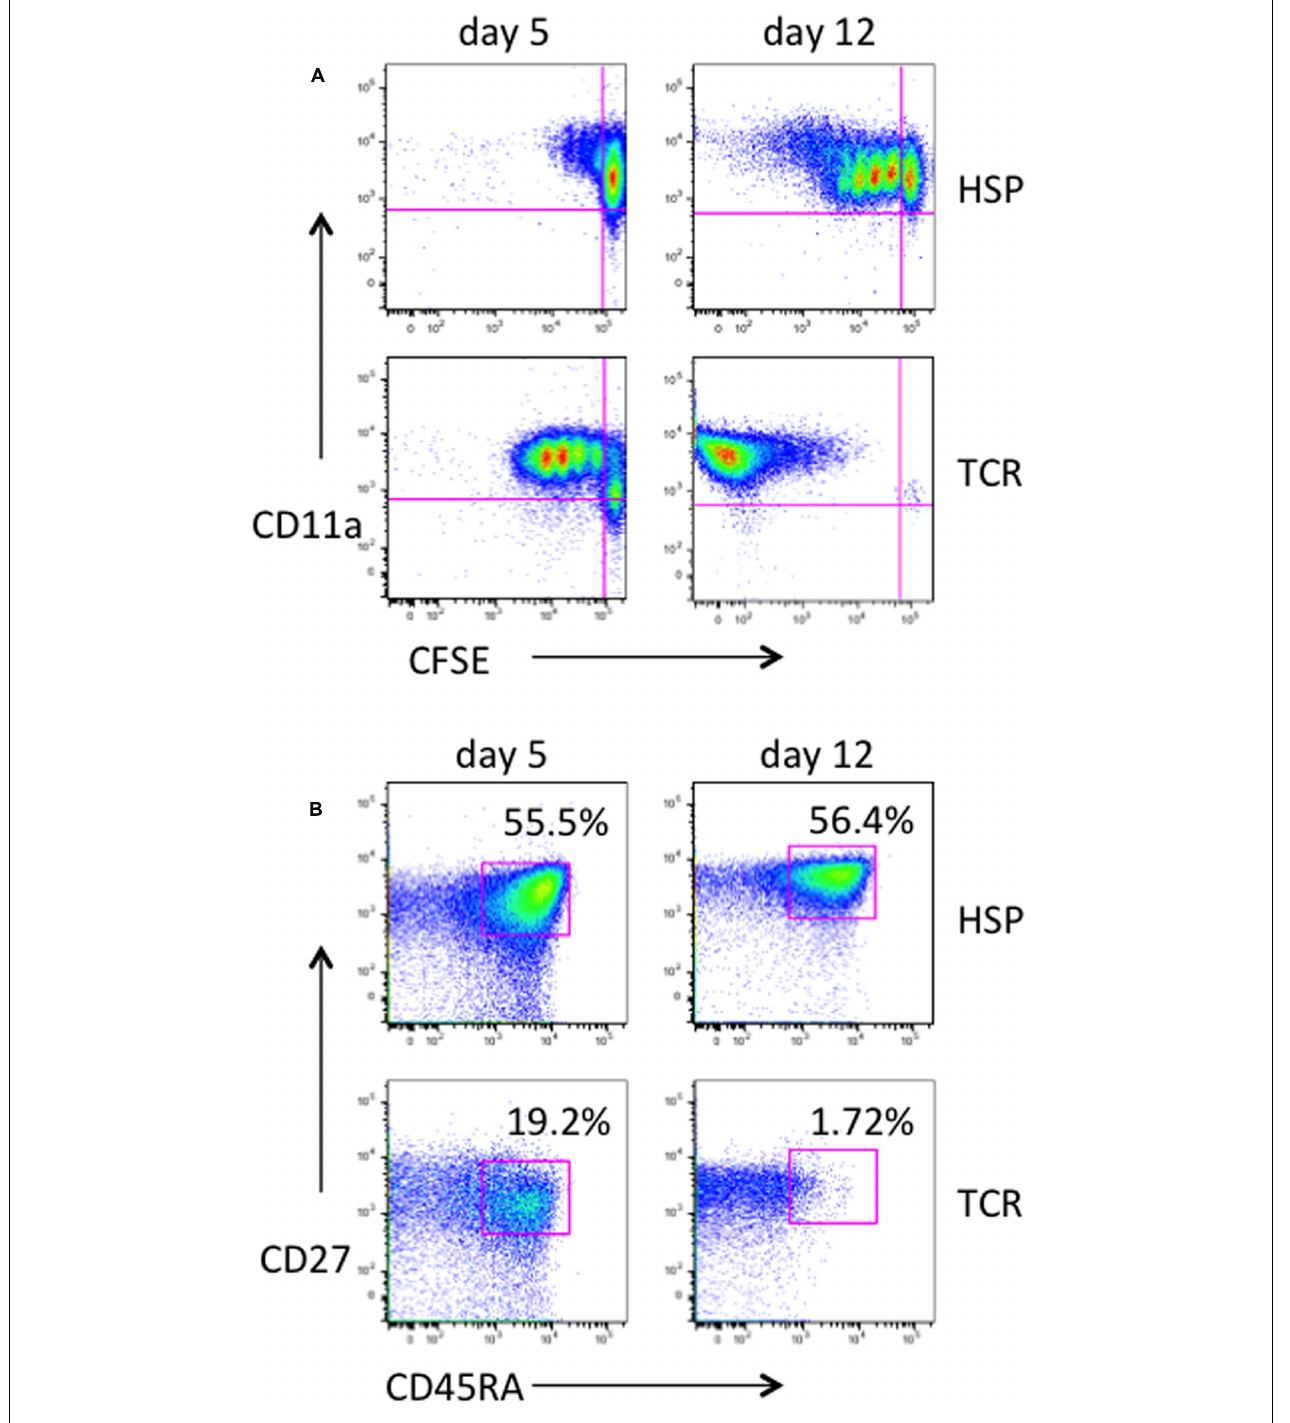
FIGURE 1 | Characterization of homeostatic proliferation of primary human CD4 + T cells. Primary CD4 T cells were purified from PBMC of healthy donors, labeled with CFSE and cultured under homeostatic conditions with 10 ng/mL of both IL-7 and IL-15 (HSP culture). As controls, CD4 T cells were stimulated with plate-coated anti-CD3 mAb at 5 µ g/mL and 1 µ g/mL anti-CD28 mAb, and kept in culture in the presence of 40U IL-2 (TCR culture). At days 5 and 12, cells were collected, stained with PerCP-CD4, PE-Cy7-CD45RA, Alexa Fluor 700-CD27, and Alexa Fluor 647-CD11a, and analyzed by flow cytometry. Live and CD4-positive cells were gated. Dot plots of CD11a expression against CFSE are shown for HSP culture and controls (A) . The majority of cells under homeostatic culture conditions as opposed to the TCR-stimulated control population remained in a naive phenotype as judged by CD27 and CD45RA expression (B) . Percentages of naïve cells are